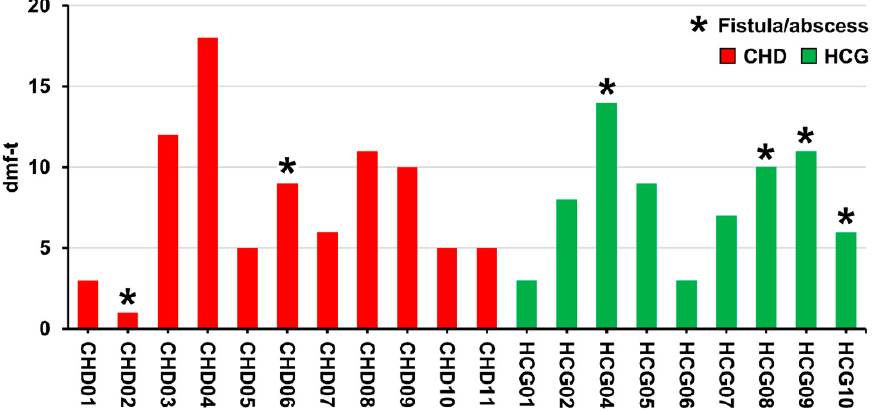
Figure 1. Bar chart of dmf-t values for each patient with congenital heart disease (CHD) or healthy control group (HCG).